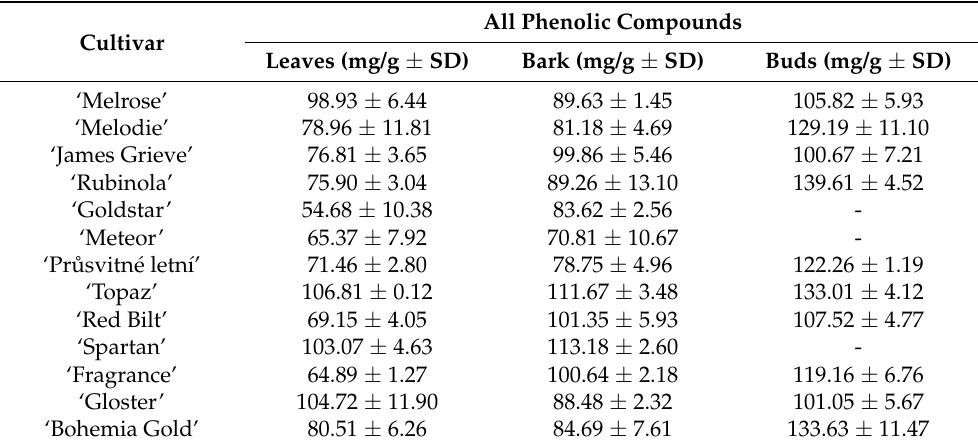
Table 2. Content of all phenolic compounds expressed in mg/g DW obtained from apple leaves, bark, and buds.